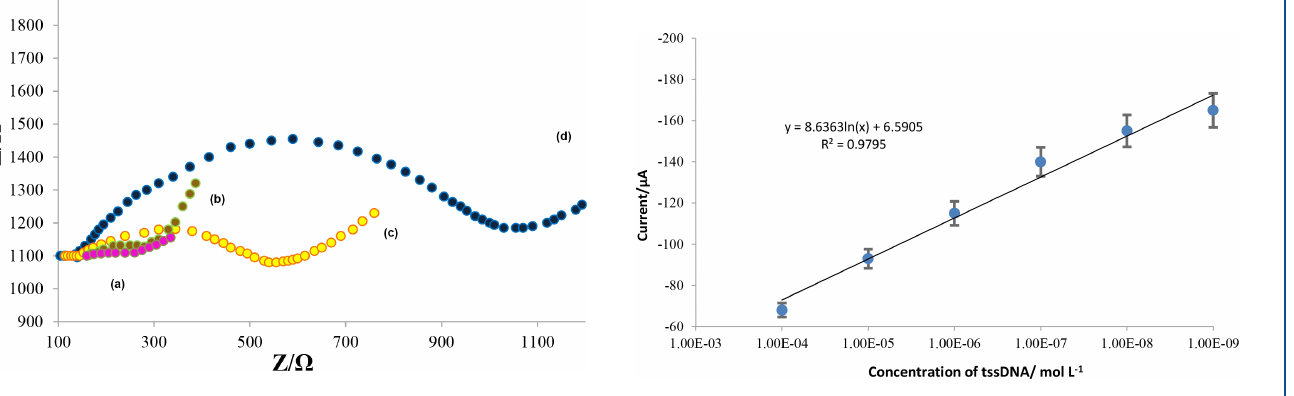
Figure 6. Calibration diagram of hybridized pssDNA with various concentrations of Aeromonas hydrophila tssDNA (1.0 × 10 − 4 , 1.0 × 10 − 5 , 1.0 × 10 − 6 , 1.0 × 10 − 7 , 1.0 × 10 − 8 , and 1.0 × 10 − 9 molL − 1 ). (curve a), 1.0 × 10 − 5 mol L − 1 (curve b), 1.0 × 10 − 6 mol L − 1 (curve c), 1.0 × 10 − 7 mol L − 1 (curve d), 1.0 × 10 − 8 mol L − 1 (curve e), and 1.0 × 10 − 9 mol L − 1 (curve f). This test was performed in a 10 mL electrolyte cell (50 mM Tris-HCl, 100 mM NaCl, 15 mM KCl, 10 mM MgCl 2 , and 5 %